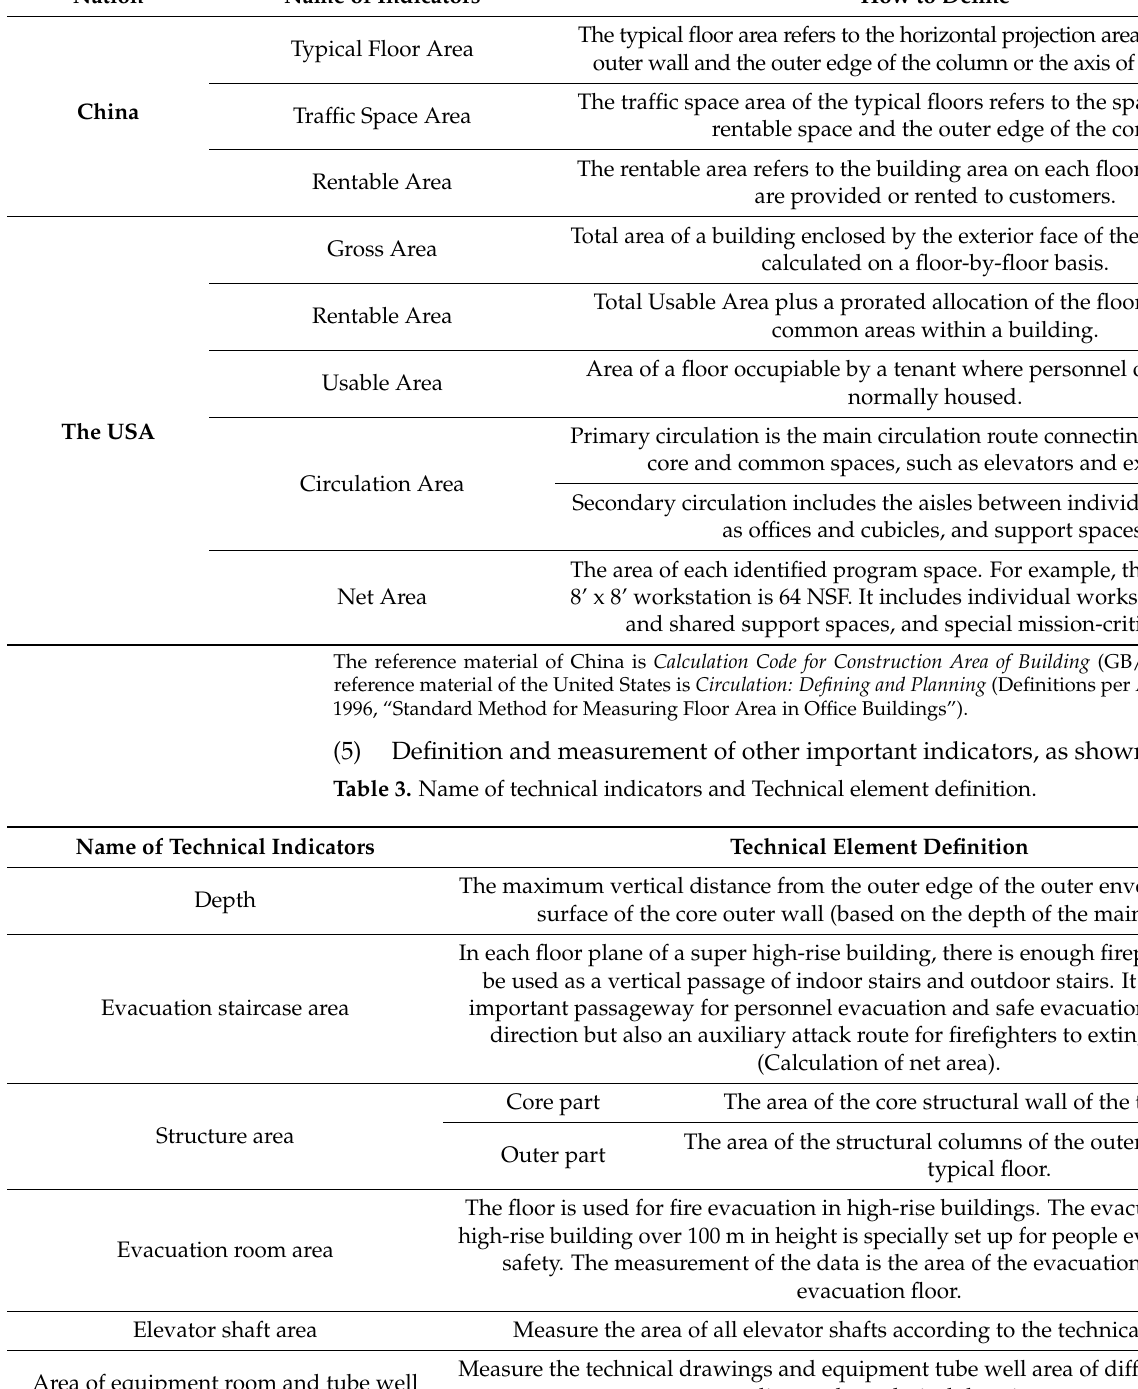
Table 2. Definition of area indicators in China and the USA.